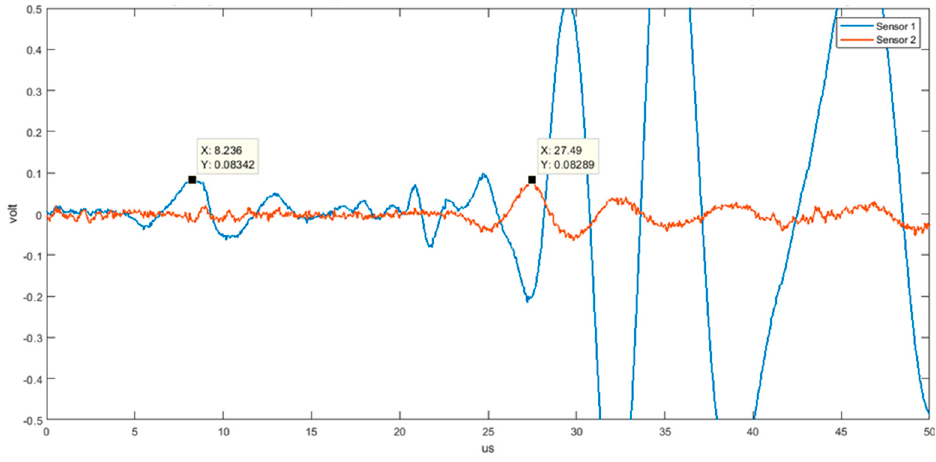
Figure 10. Zoom of Figure 9 on a 50 µs time window for the S 0 mode signals.